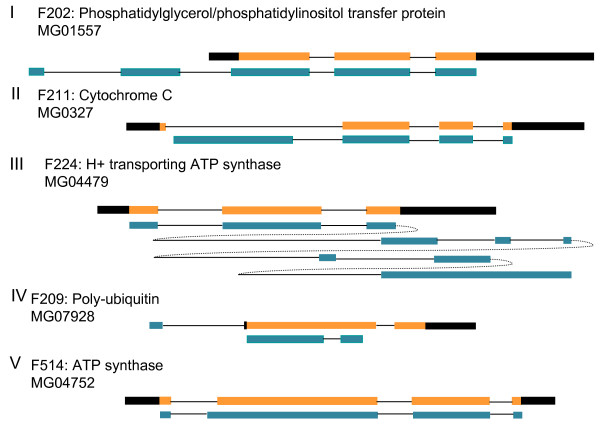
Five types of errorneous gene model were illustrated. Orange bar represents exon region translated from cDNA sequences, blue bars represent exon region, black bars 5' and 3' untranslated region, and line intron region, respectively. Extremely long intron was described as dotted line in type III.